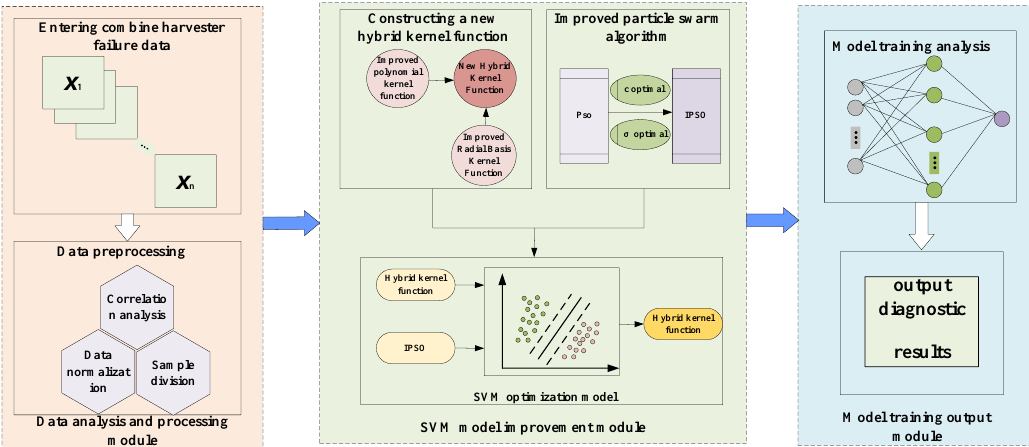
Figure 2. Structure diagram of fault diagnosis of combine harvester.